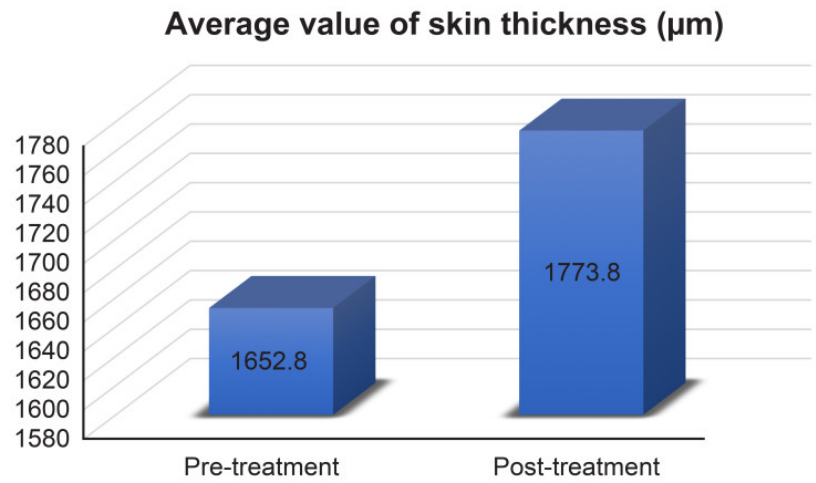
Figure 4. Average values of skin thickness measurement results. Pre-treatment 1652.8 ± 302.064μm, post-treatment 1773.8 ± 293.577μm.